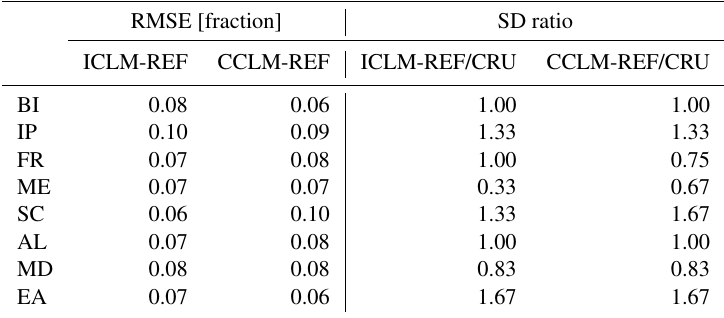
Table 9. Same as Table 4 but for total cloud